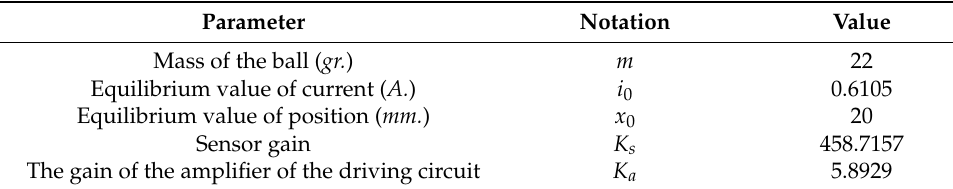
Table 1. Parameters of the Maglev System. Parameter Notation Value Mass of the ball ( gr. ) 𝑚